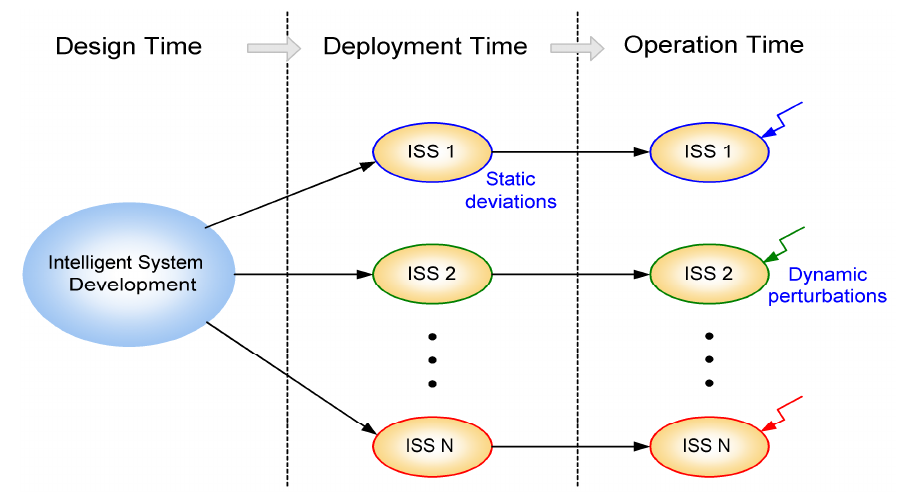
Figure 6. Three different phases of the system design and application